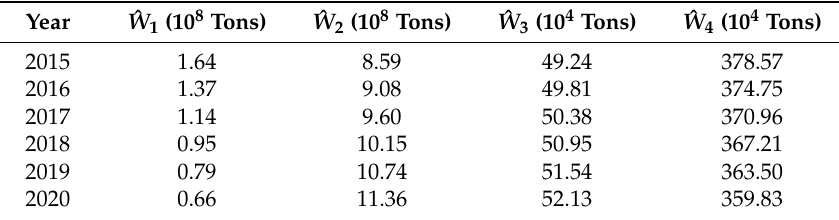
Table 8. Prediction results of main water pollutant annual emissions in the Three Gorges reservoir